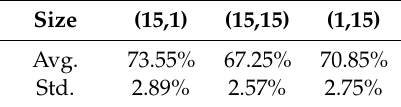
Table 7. Test accuracy using di ff erent kernel shapes in the 2D network.